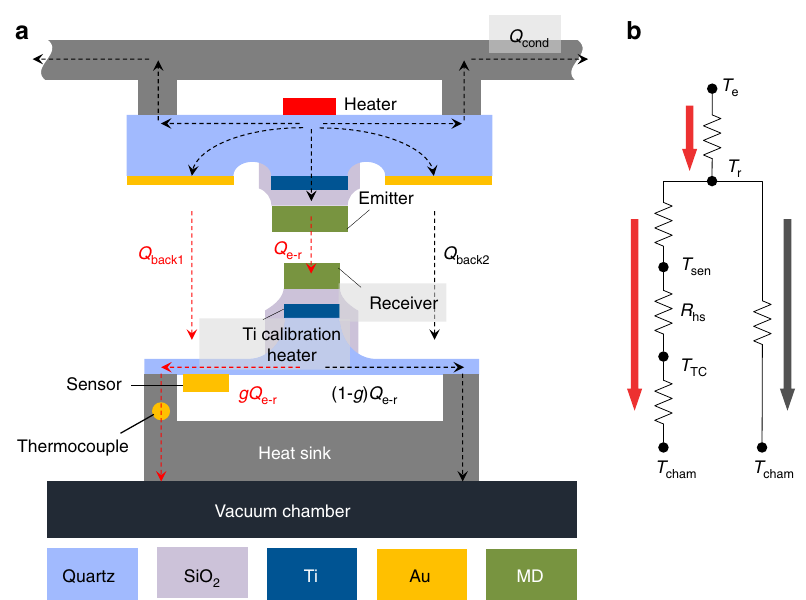
Fig. 3 Heat transfer analysis with experimental setup. a Schematic of enlarged cross-sectional view of MEMS-device-integrated platform showing heat fl ow. The radiative heat fl ux from the MD emitter to the MD receiver Q e → r can be estimated from the measured temperature difference between the backside temperature sensor and the thermocouple on the heat sink. b Equivalent thermal circuit for experimental